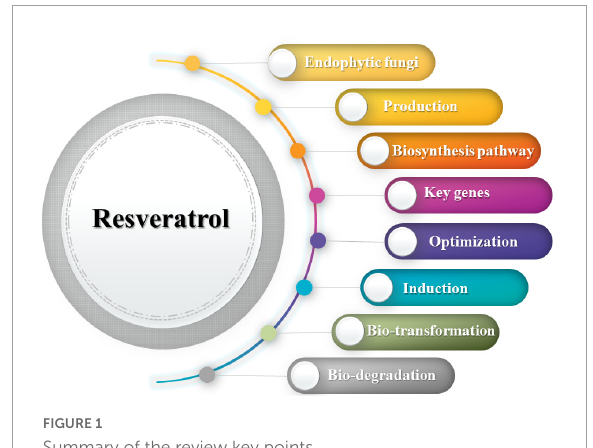
FIGURE1 Summary of the review key